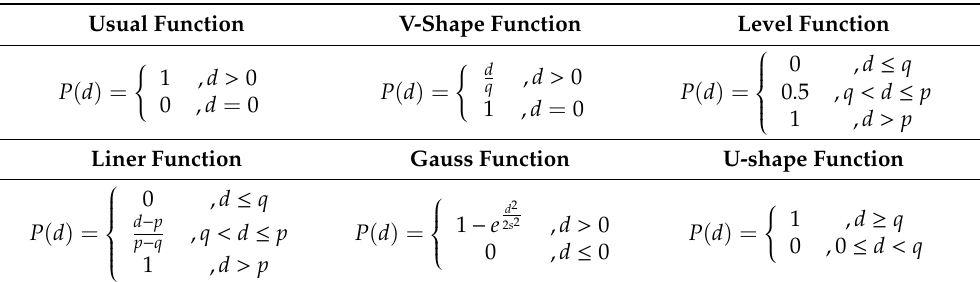
Table 1. q , p and s are three parameters of the preference function: q is the indi ff erence threshold, p is the absolute preference threshold, and s is a value between p and q. Table 1. Preference